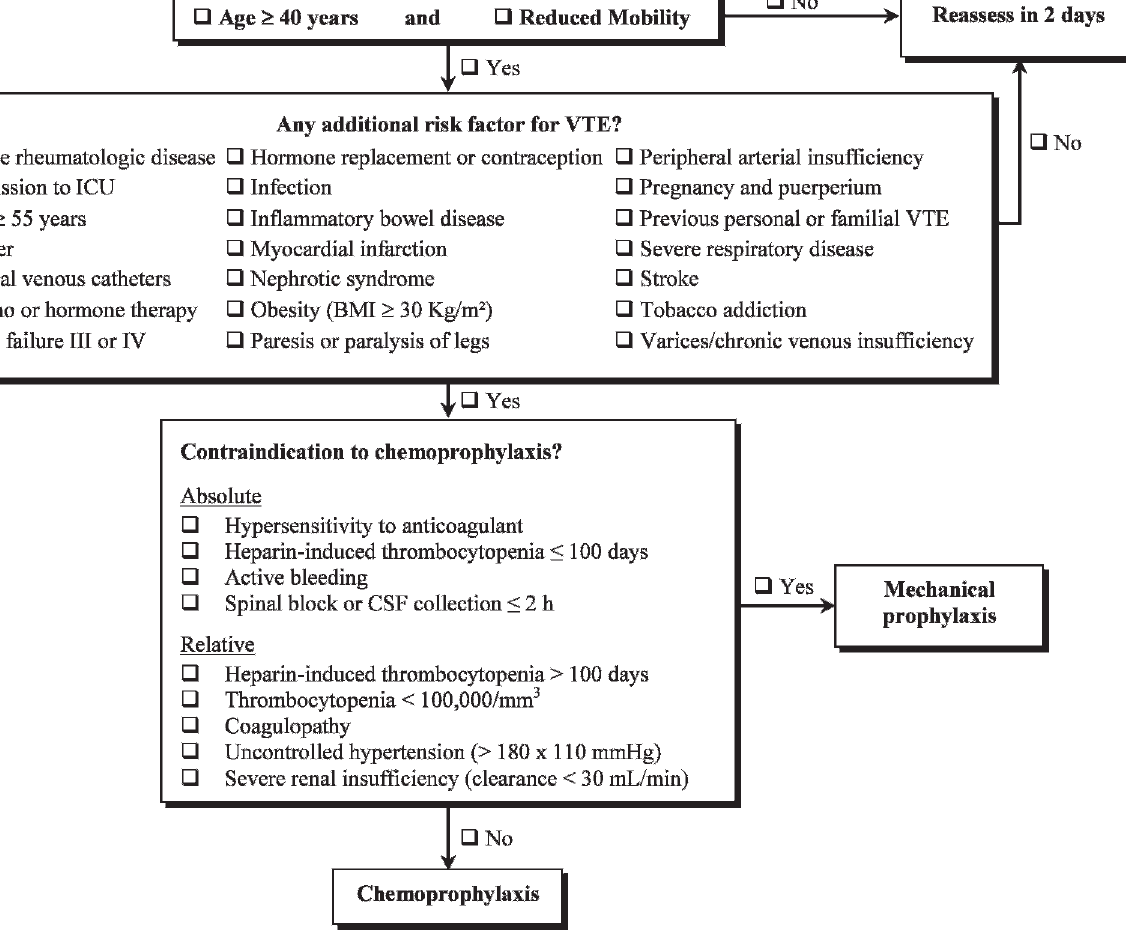
Figure 1 - Algorithm from the Brazilian Guidelines for VTE Prophylaxis in Hospitalised